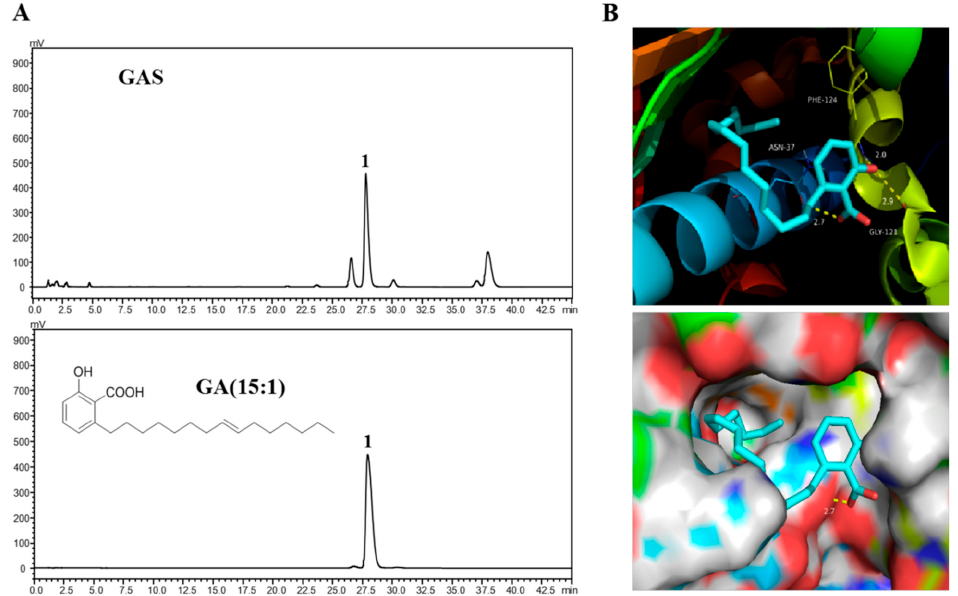
Figure 5. Molecular docking model of GA (15:1) with Hsp90 α . ( A ) Chemical structure of GA (15:1). ( B ) Docking position of GA (15:1) in the active site of the Hsp90 α N-terminal. Key amino acid residues within the binding site are indicated using capped sticks.